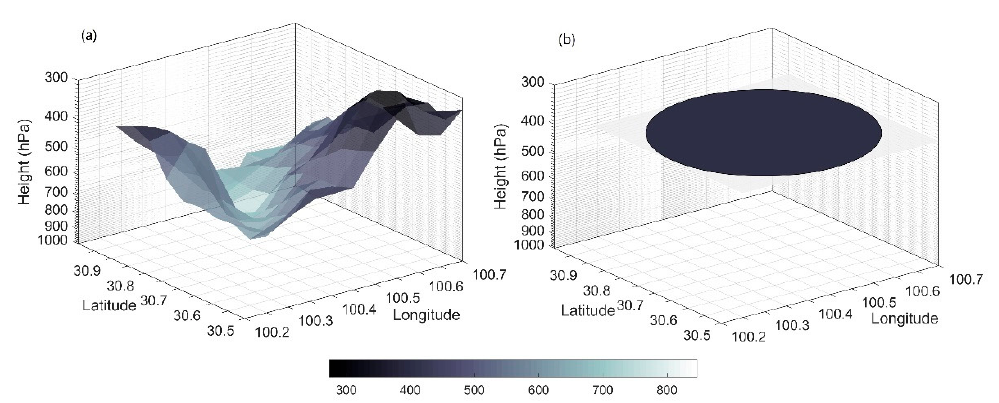
Figure 5. Schematic diagram of unified cloud top height. ( a ) Real-time cloud height for Medium Resolution Spectral Imager-2 (MERSI-2) pixels before applying our “remap” method, and ( b ) the unified cloud top height for Microwave Temperature Sounder 2 (MWTS)-2 pixels after remap.